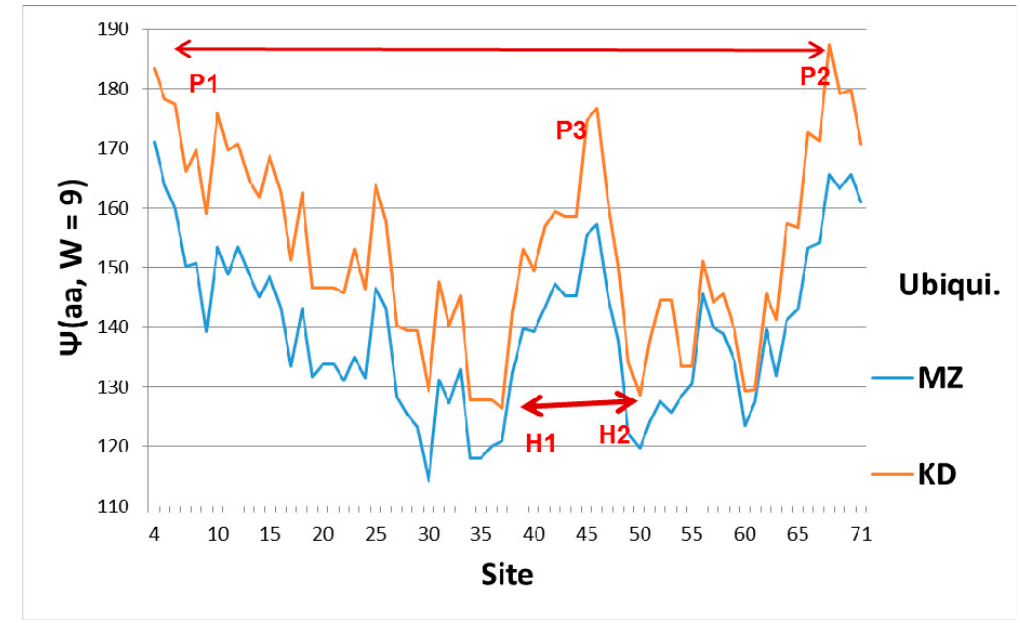
Figure 1. Hydropathic profiles with sliding window width W = 9 (smallest value associated with MZ scale, and highest resolution) for ubiquitin. Sites are numbered from N terminal to C terminal, and the two scale centers have been slightly offset for clarity, with larger values being more hydrophobic, and smaller values more hydrophilic. Hydroneutral is approximately 155 on both scales. The overall shape is roughly that of a symmetrical parabolic bowl, with a hydrophobic peak P3 ~45 functioning as an elastic pivot in the center. Thus the N and C terminal wings can swing separately, facilitating tagging the opposite sides of a crack in the strain field of a diseased protein. The average hydropathicity of ubiquitin is hydrophilic, which means it is elastically softer than average, which again facilitates tagging diseased cracks near the N and C terminals. The hydrophobic N (P1) and C (P2) terminal peaks are nearly level, which facilitates synchronous tagging, as are the hydrophilic hinges H1 and H2.